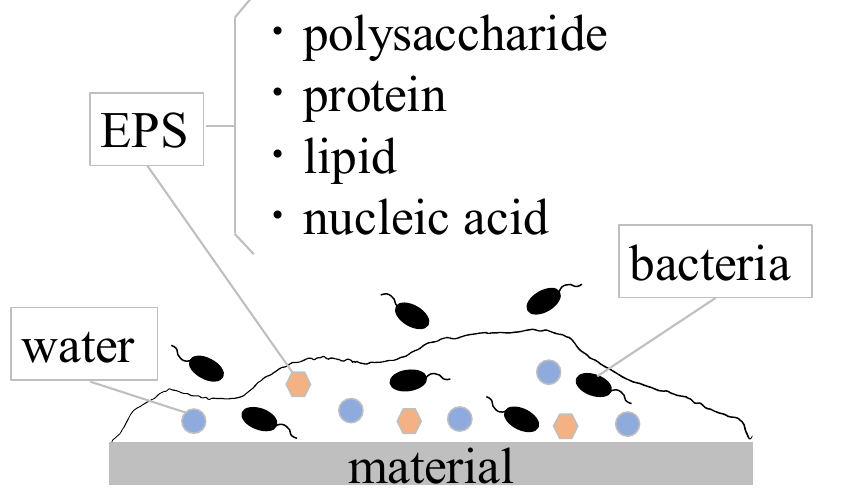
Figure 1. Schematic diagram of biofilms on materials.